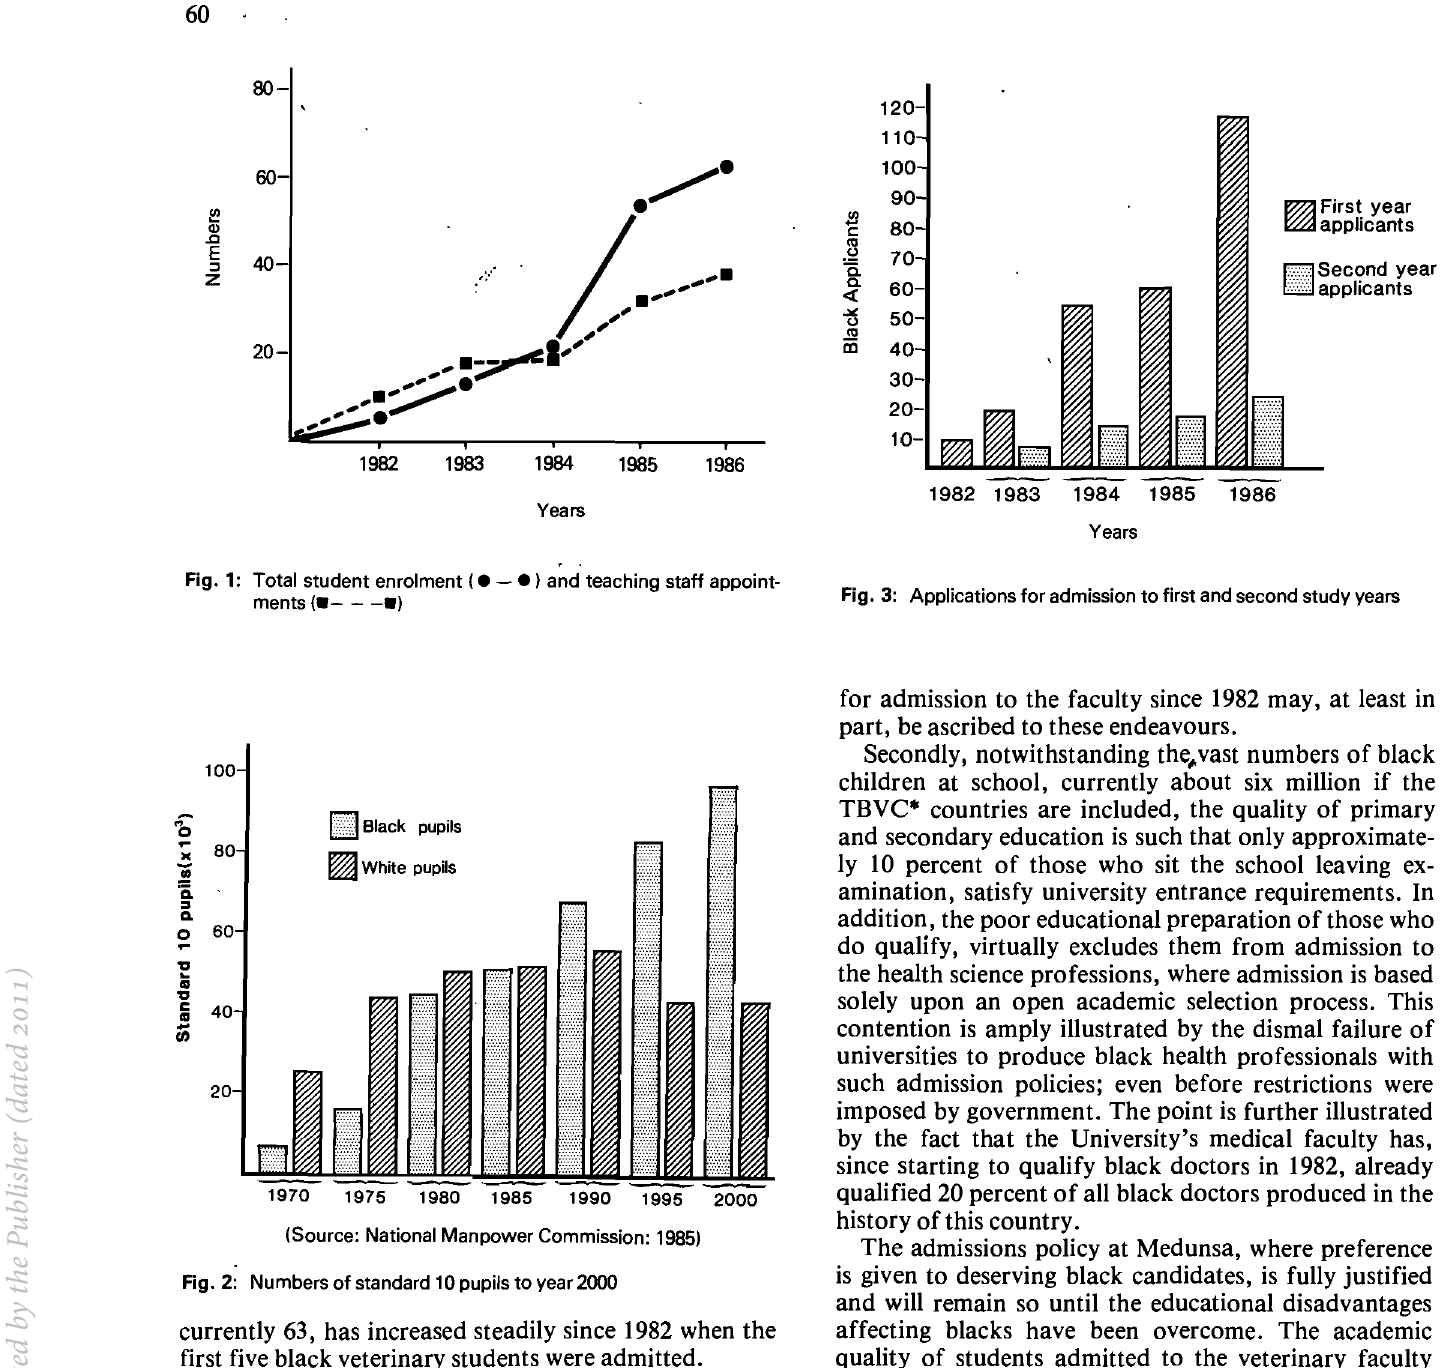
Fig. 2: Numbers of standard 10 pupils to year 2000